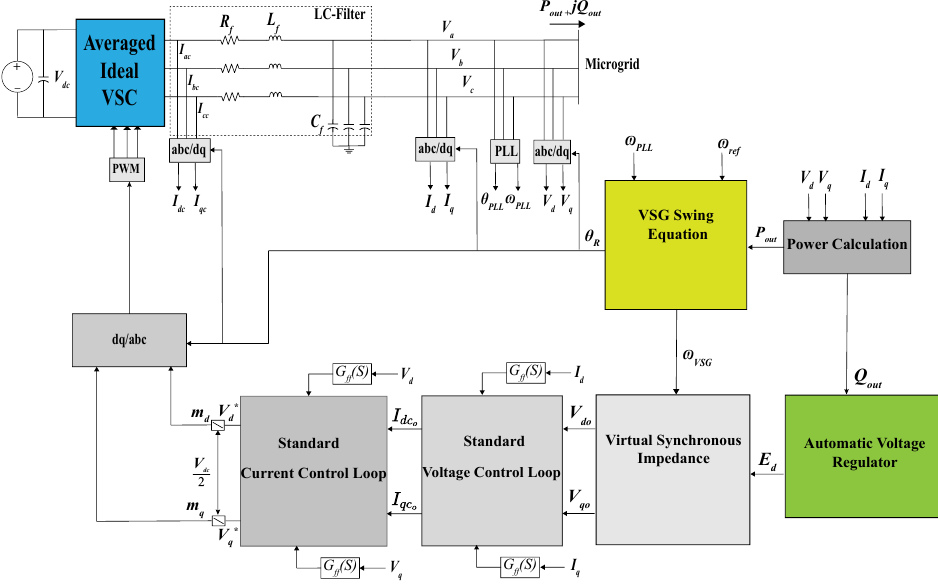
Figure 1. Generic virtual synchronous generator (VSG) based on average model(Reprinted/adapted with permission from Ref. [6]. 2022,